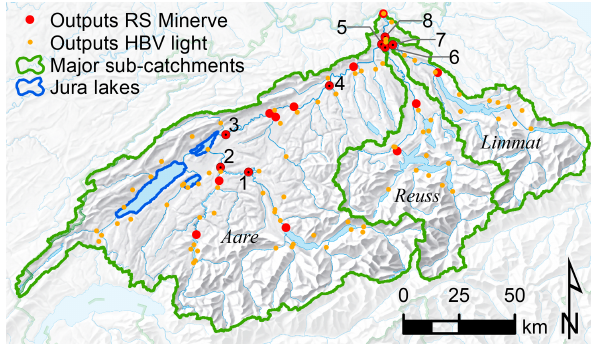
Figure 2. Overview map of the Aare River basin, showing model outputs of HBV light (orange) and RS MINERVE (red) as well as the two major sub-basins (Reuss and Limmat rivers) (green). Re- sults from RS MINERVE are discussed further below for the Aare River at Halen (1), Golaten (2), Brügg–Aegerten (similar to the Lake Biel outlet) (3), Aarburg (4) and Brugg (5); the Reuss River outlet (6); the Limmat River outlet (7); and the Aare River at Stilli (close to its outlet) (8). Map background: Federal Office of Topog- raphy